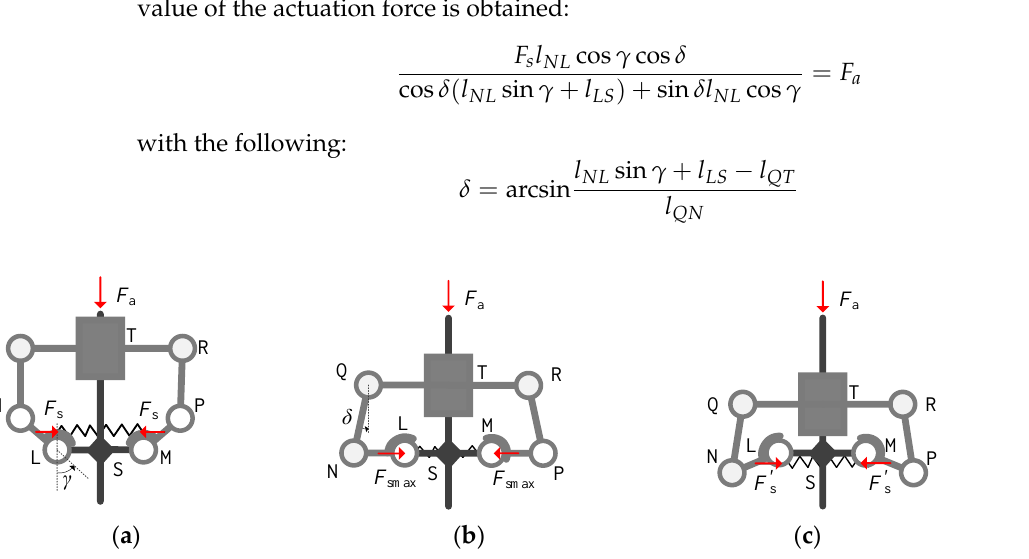
Figure 6. Schematic diagram of force distribution for the compaction mechanism conforming a surface in both ( a ) the compliant state and ( b ) the stiff state, illustrating the actuation force 𝐹 𝑎 , contact forces 𝐹 𝑓 and 𝐹 𝐺 , and the frame forces 𝐹 𝐷 and 𝐹 𝐸 .